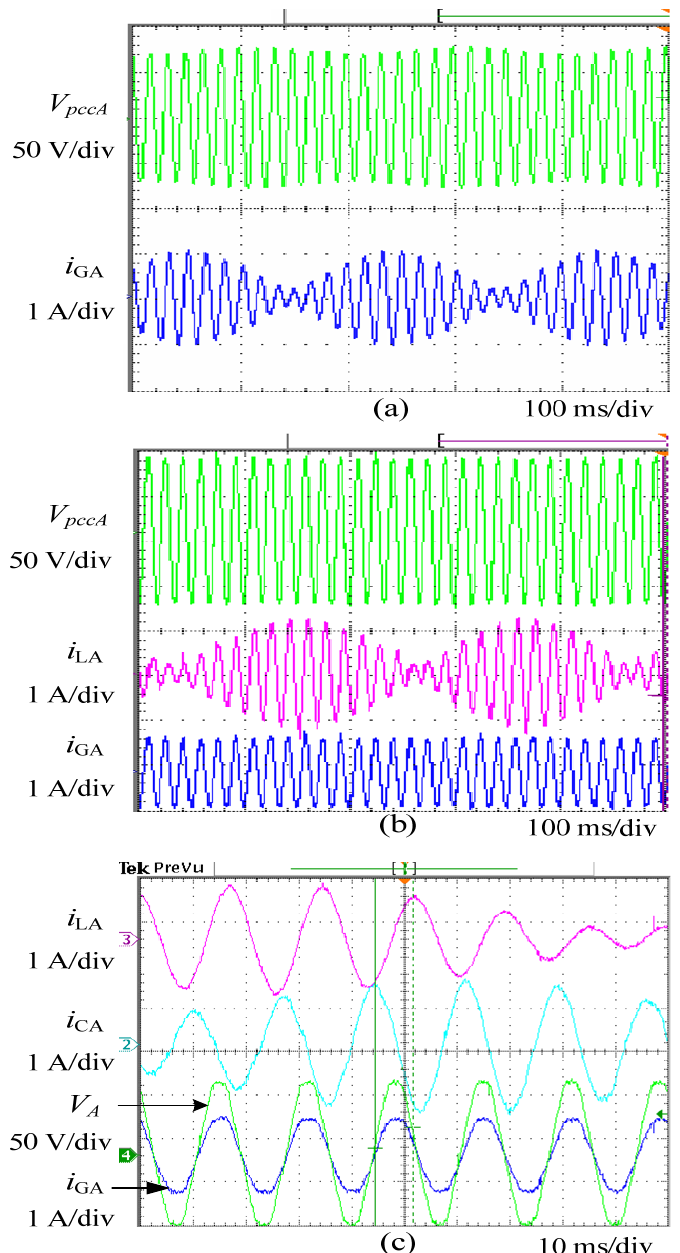
Figure 20. Experimental waveforms of the voltage flicker compensation. ( a ) Coupling-point phase voltage ( V pccA ) and grid current ( i GA ) without compensation; ( b ) Coupling-point phase voltage ( V pccA ), load current ( i LA ), and grid phase current ( i GA ) with reactive power compensation; ( c ) Zoomed load current ( i LA ), STATCOM current ( i CA ), grid phase voltage ( V A ), and grid phase current ( i GA ) with reactive power compensation.